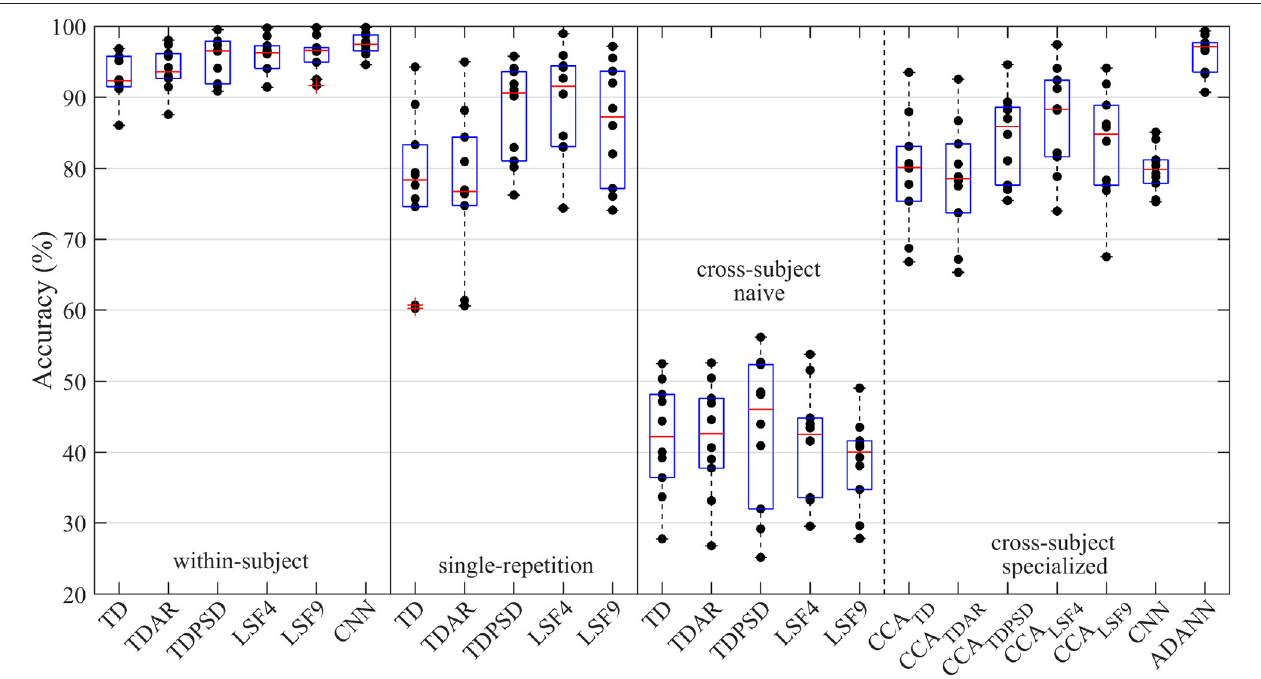
FIGURE 2 | Accuracy of the intact-limb gesture recognition pipelines explored throughout the study. The pipelines were categorized according to their evaluation framework: within-subject, single-repetition, or cross-subject. The cross-subject framework was further divided into naive cross-subject pipelines and specialized cross-subject pipelines. These signified the absence or presence of a cross-subject specific solution leveraged to minimize the accuracy degradation due to between-subject variance, respectively. A dot represents the average accuracy across all gestures for a intact-limb subject using a particular gesture recognition pipeline; whereas the boxplot represents the distribution of accuracies among intact-limb